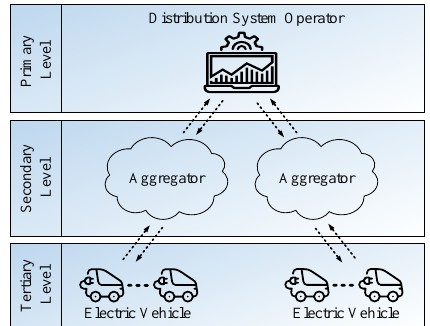
Figure 1. Hierarchical control